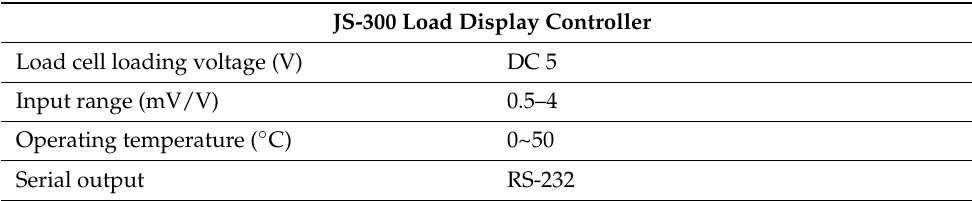
Table 6. Specifications of JS-300 load display